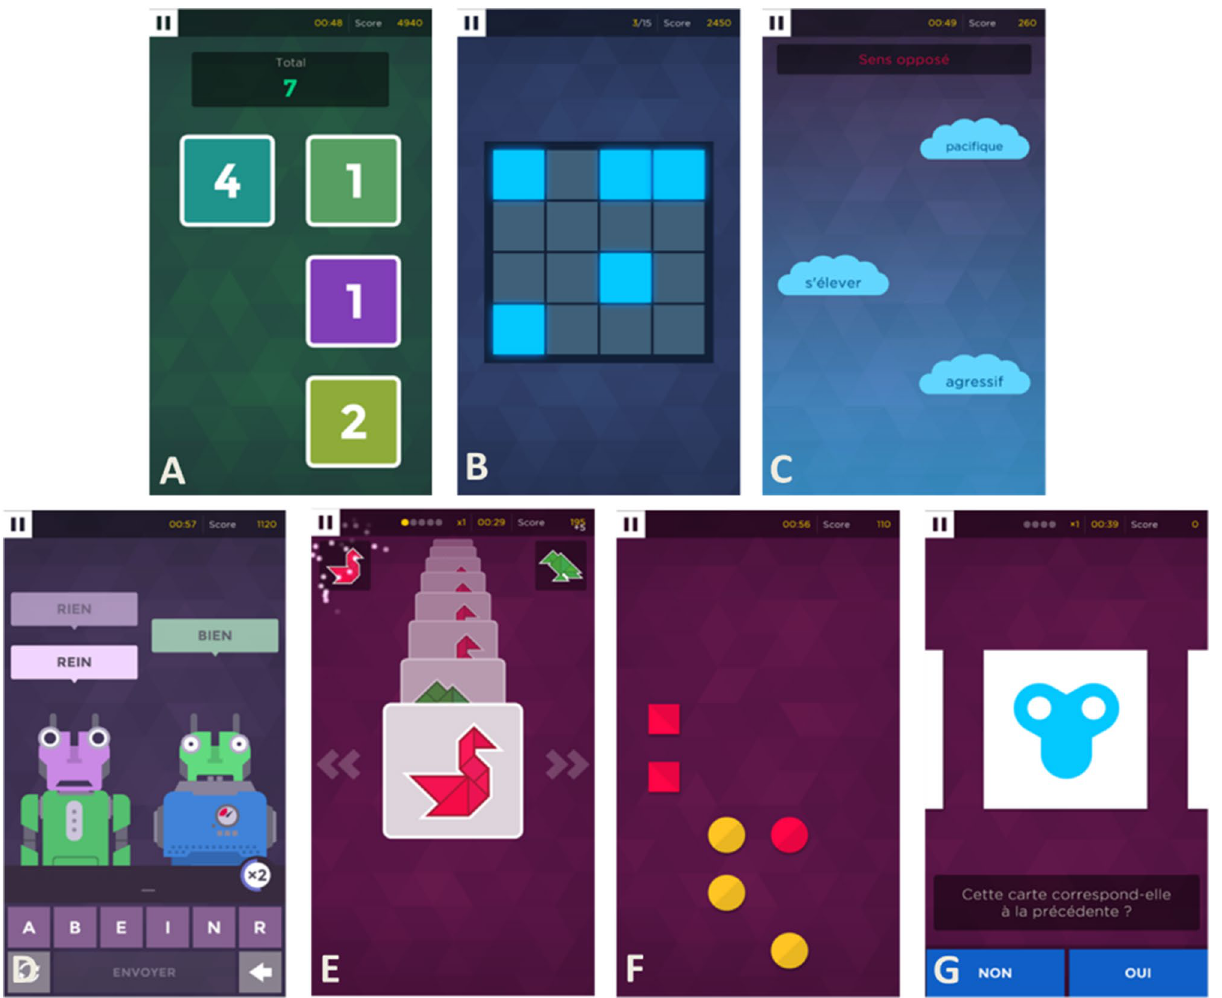
Figure 3. Screenshots of the 7 CMG used in this study. ( A ) Square Numbers, ( B ) Memory Sweep, ( C ) Word Pair, ( D ) Babble Bots, ( E ) Must Sort, ( F ) Unique, ( G ) Rush Back. Instructions and main cognitive abilities trained of each CMG are presented in Table